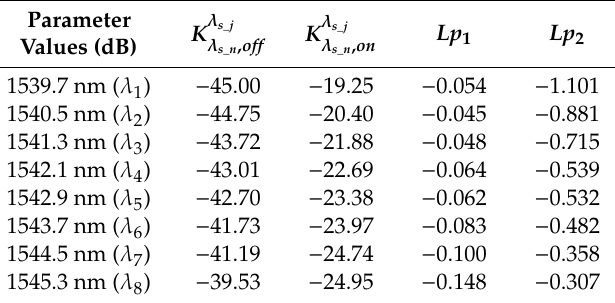
Table 2. Parameters of basic optical switching elements (BOSEs)